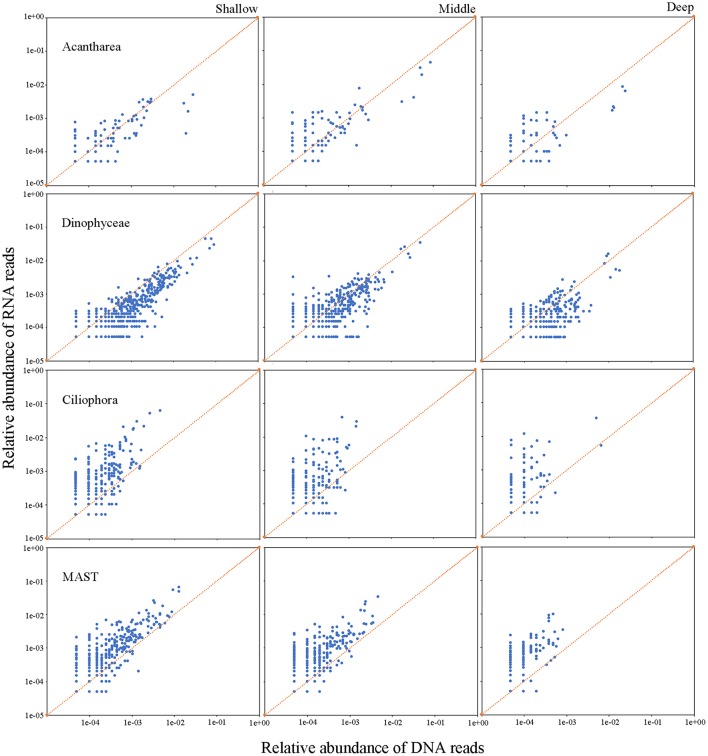
Relative abundance of RNA (y-axis) and DNA (x-axis) reads for each OTU in representative microbial eukaryotes assemblages, Acantharea, Dinophyceae, Ciliophora, and MAST, in the water column of the South China Sea.